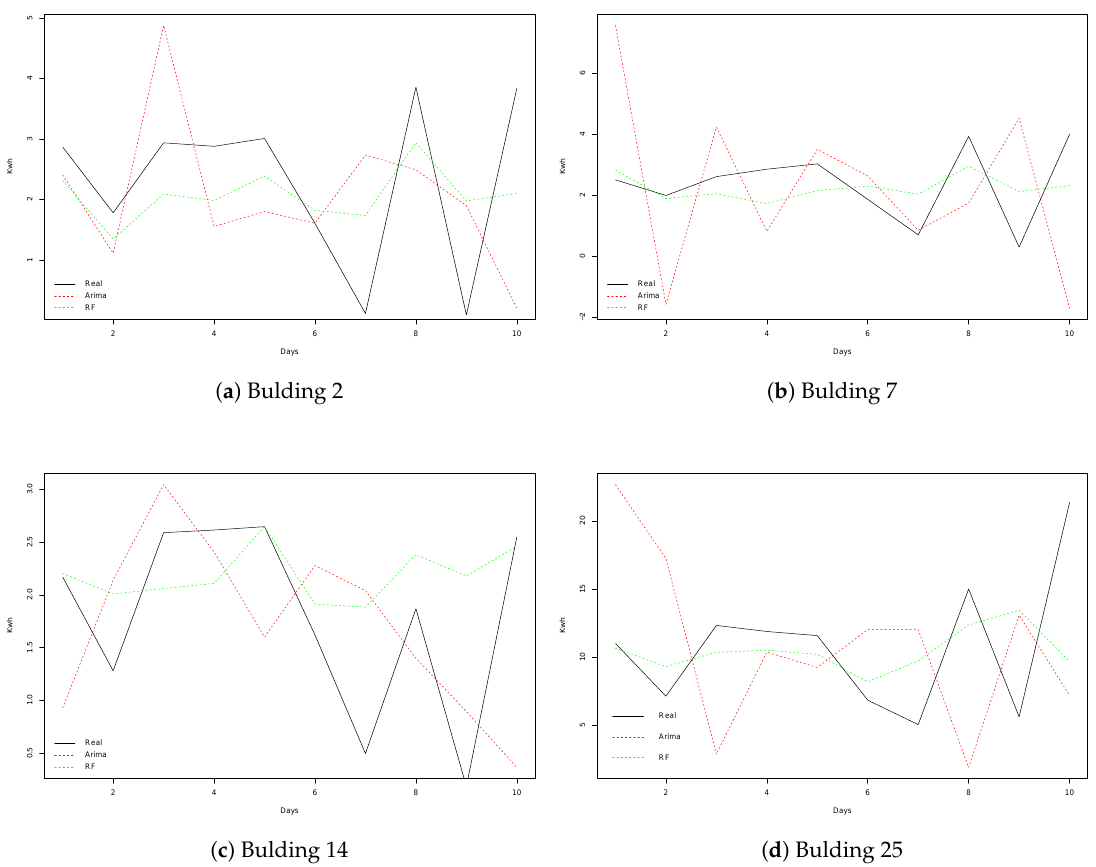
Figure 7. Four examples of real data against the predictions from ARIMA and Random Forest for w =